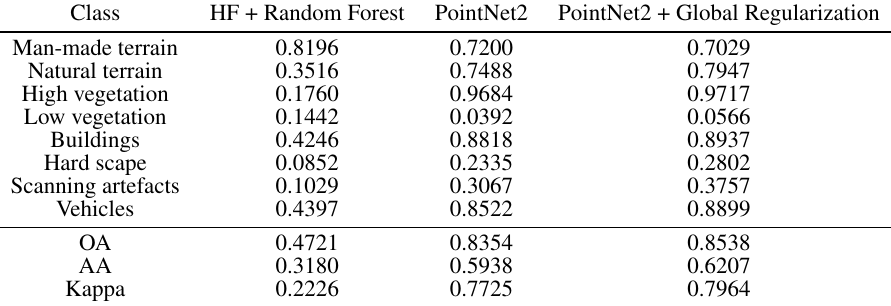
Table 1. Classification accuracy for different classification methods using TUM